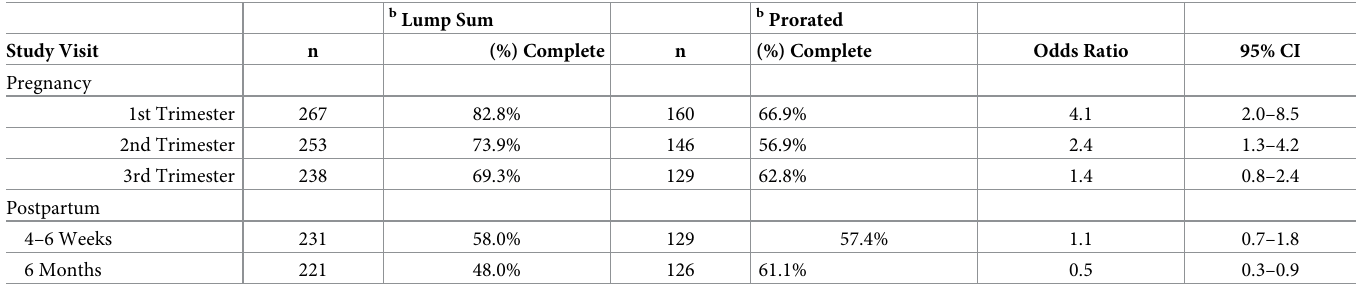
Table 3. Dietary record completion (n, %) and OR (95% CI) of dietary record completion associated with remuneration schedule a